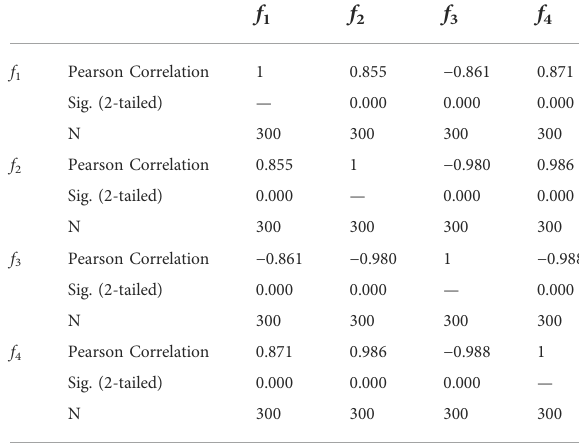
TABLE 2 Comparison of objective function values between the proposed joint DG-substation optimization and other methods. Obj